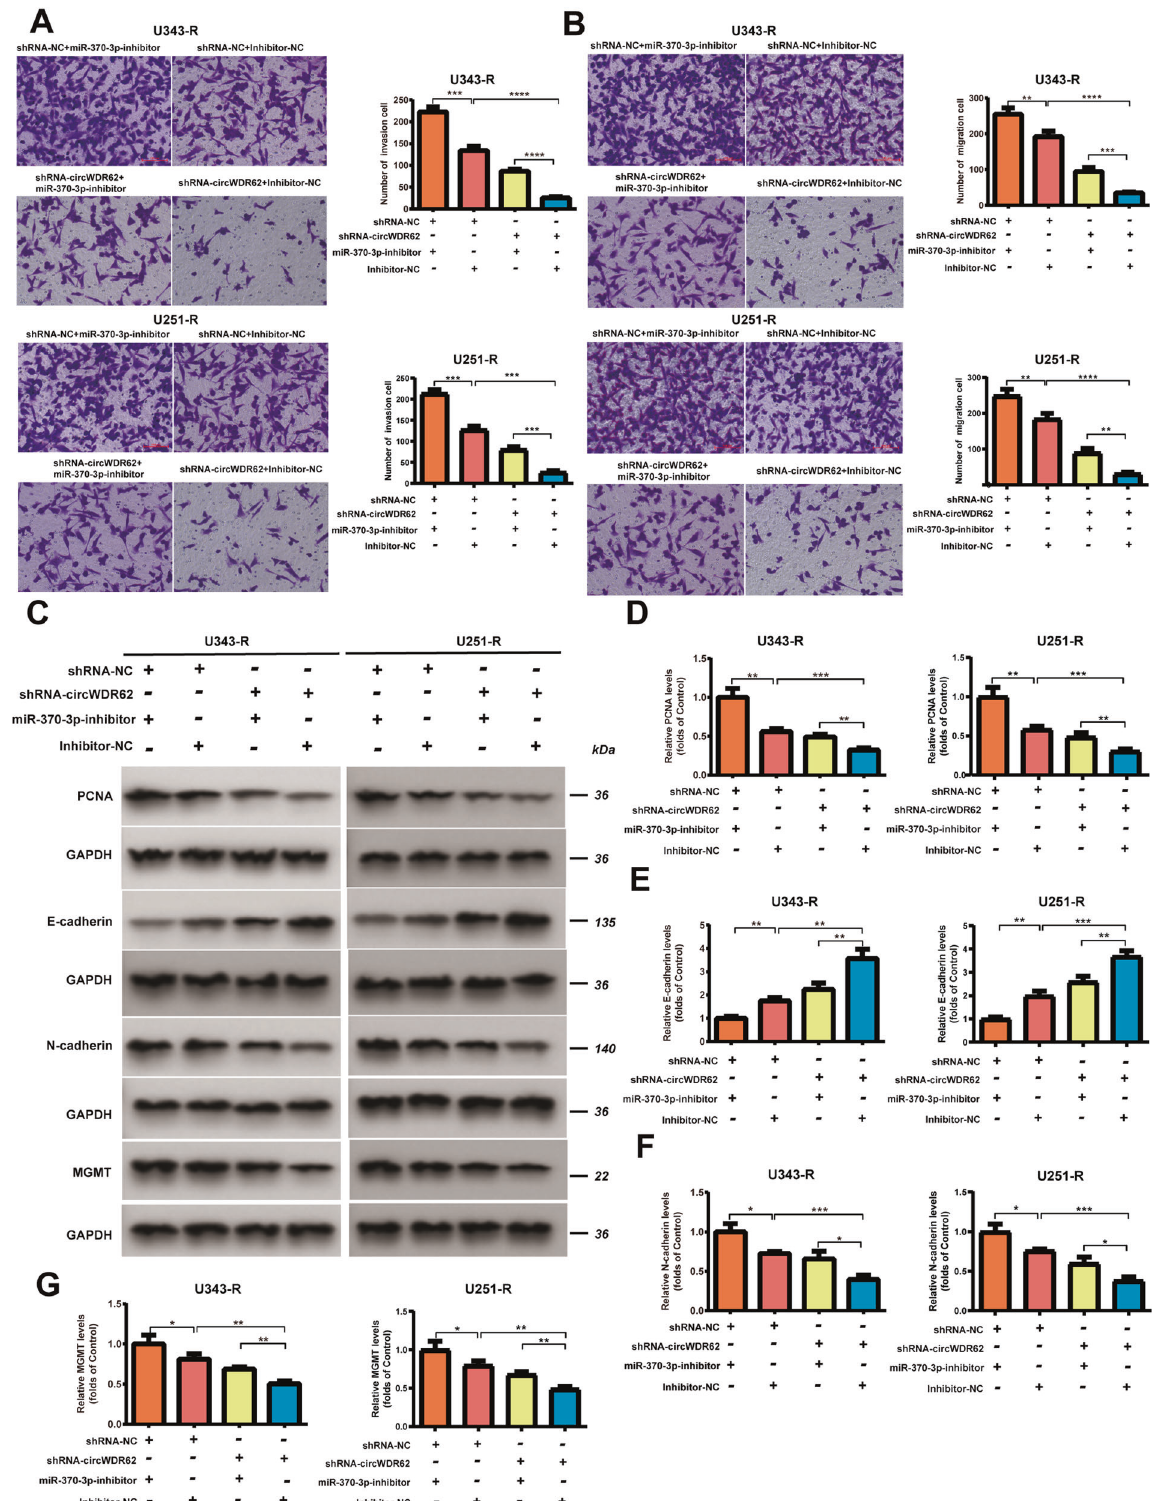
Fig. 3 circWDR62 promotes cell invasion and migration by acting as a sponge of miR-370-3p. U343-R and U251-R cells were transfected with shRNA-NC or shRNA-circWDR62 and miR-370-3p inhibitor or inhibitor-NC. A-B Transwell assays were performed to assess the invasion ( A ) and migration ( B ) of U343-R and U251-R cells. C – G The protein expression levels of PCNA ( D ), E-cadherin ( E ), N-cadherin ( F ) and MGMT ( G ) were measured by WB